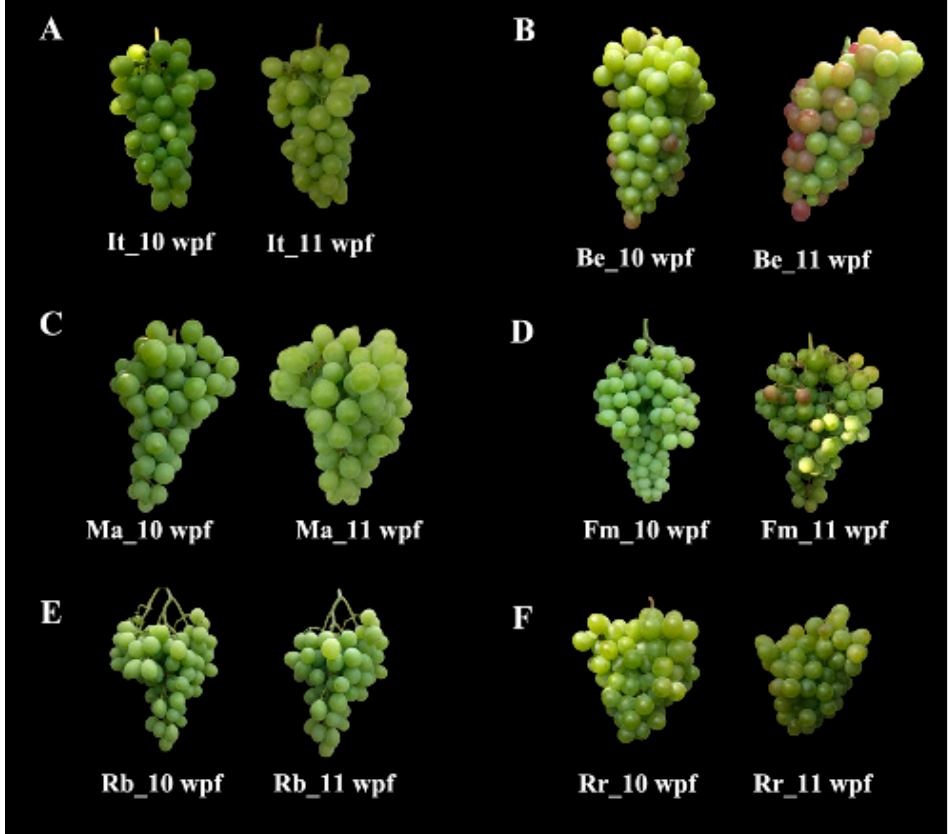
Figure 2. Fruit clusters of six varieties during véraison period (10 wpf and 11 wpf). ( A ) ‘Italia’ berries at 10 and 11 wpf; ( B ) ‘Benitaka’ berries at 10 and 11 wpf; ( C ) ‘Muscat of Alexandria’ berries at 10 and 11 wpf; ( D ) ‘Flame Muscat’ berries at 10 and 11 wpf; ( E ) ‘Rosario Bianco’ berries at 10 and 11 wpf; ( F ) ‘Rosario Rosso’ berries at 10 and 11 wpf.